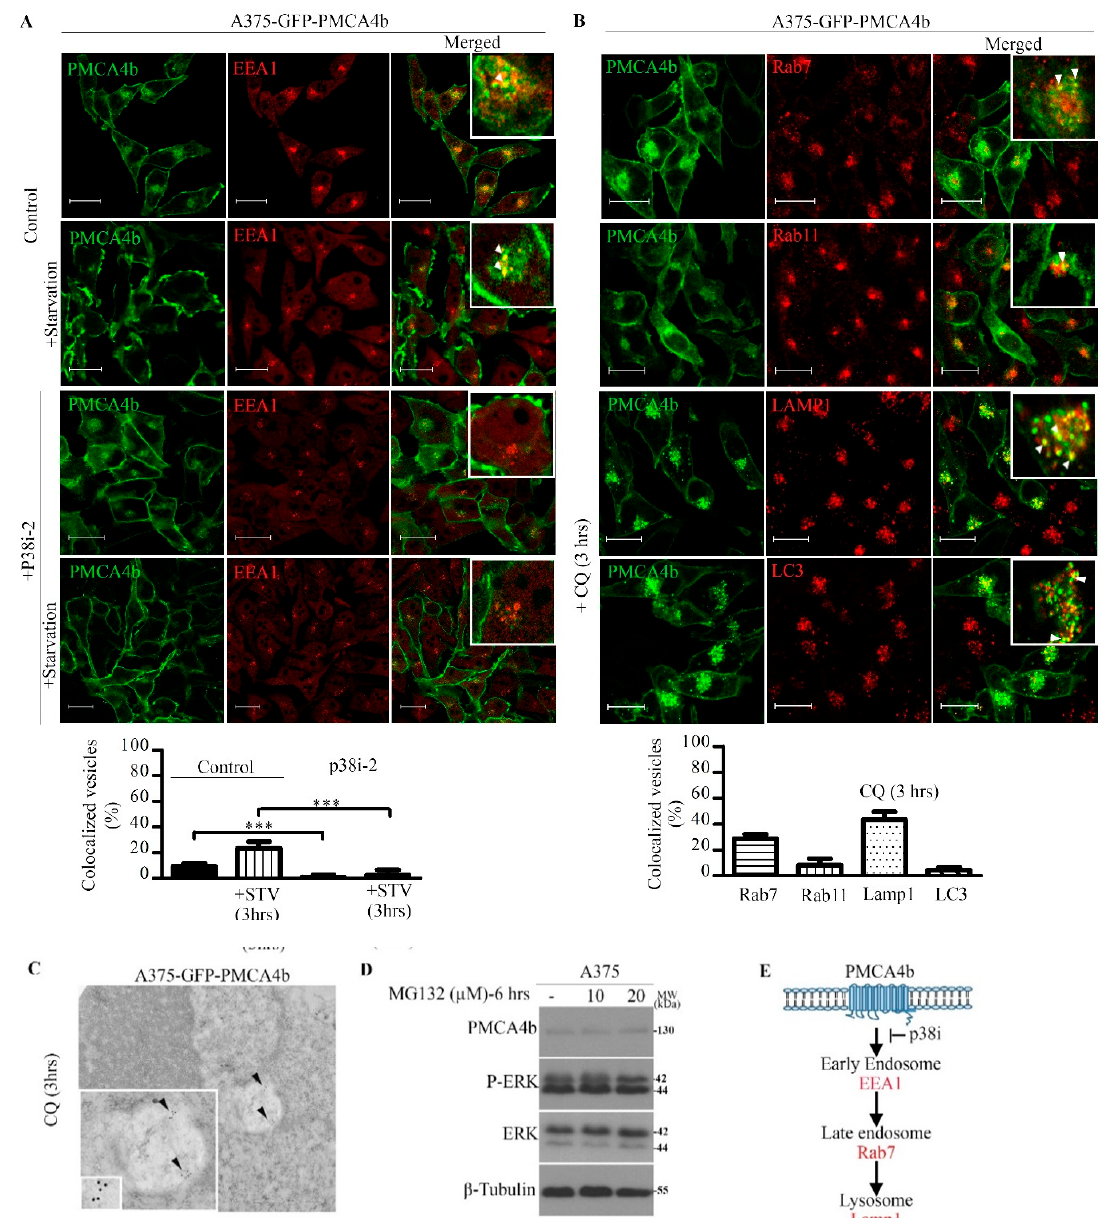
Figure 3. P38 inhibitor abolished GFP-PMCA4b internalization in A375 cells, and chloroquine (CQ) trapped the pump in LAMP1 positive intracellular organelles. ( A ) Confocal microscopy images of A375-GFP-PMCA4b cells after treatment with 10 µ M p38i-2 inhibitor (SB202190) for 48 h with or without starvation (3 h). The cells were immunostained for the early endosomal marker EEA1. EEA1 and GFP-PMCA4b positive (yellow) vesicles were counted (six cells / group) and expressed as % of total number of GFP-PMCA4b positive vesicles. Scale bar, 20 µ m. Bars represent means ± SE. ( B ) Confocal images of A375-GFP-PMCA4b immunostained with the endo-lysosomal markers Rab7, Rab11 and LAMP1, and the autophagy marker LC3 after treatment with CQ for 3 h. The number of GFP-PMCA4b vesicles that co-localize with the endo-lysosomal or autophagy markers were counted and expressed as a % of total number of PMCA4b positive vesicles. Seven to nine cells were counted in each group. Scale bar, 20 µ m. Bars represent means ± SE. ( A , B ) Insets show higher magnification view, Scale bar, 10 µ M. Arrowheads show co-localization of GFP-PMCA4b with endosomal markers. ( C ) A375-GFP-PMCA4b cells were cultured and treated with CQ for 3 h. Cells were fixed and immunostained with anti-GFP antibody (1:100) (Invitrogen, 1972783). Images were taken by JEM-1011 transmission electron